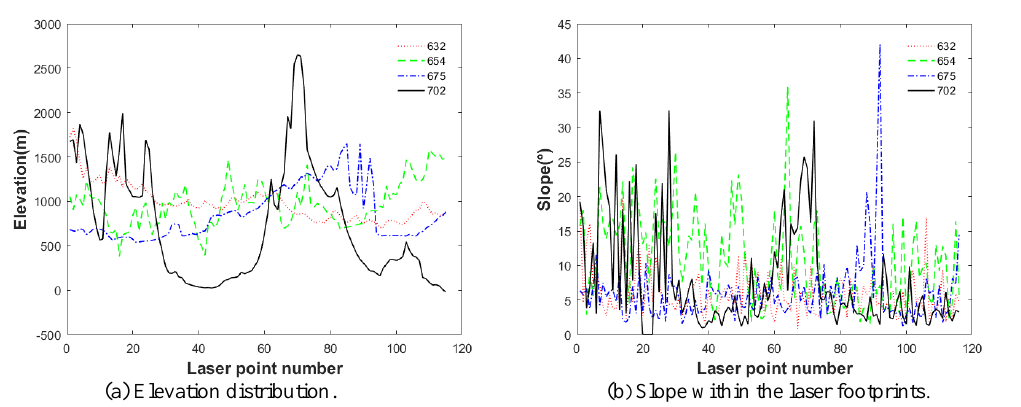
Figure 2. Distribution of elevation and slope within the laser footprints.